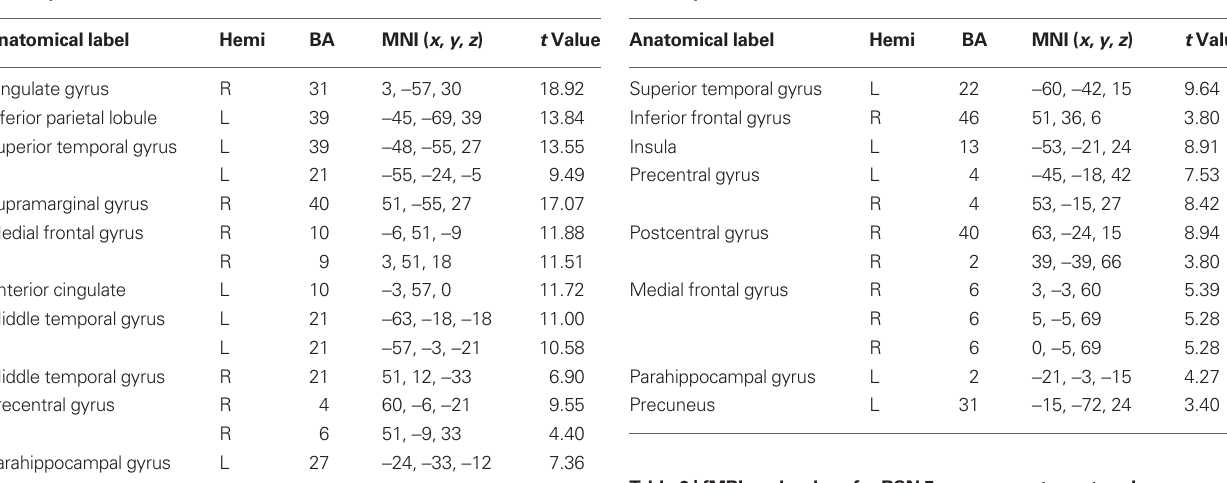
Table 6 | fMRI peak values for RSN 5 sensory motor network.